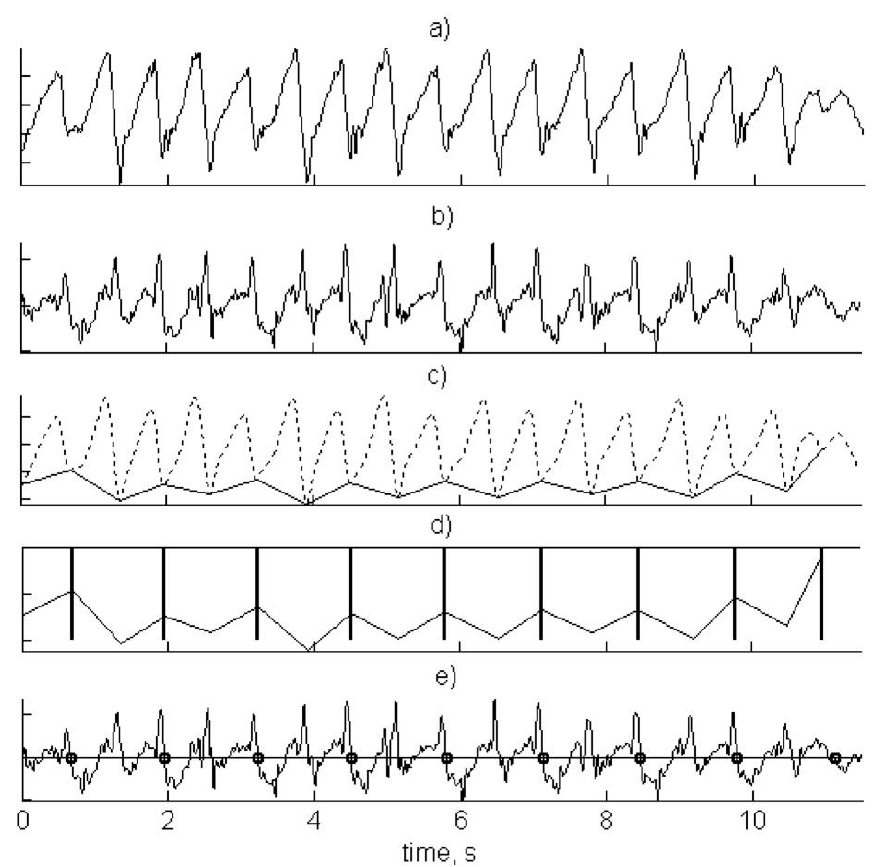
Figure 17. Stroke count detection method using back worn accelerometer: ( a ) raw vertical axis acceleration; ( b ) raw anterio-posterior axis acceleration; ( c ) filtered vertical axis acceleration; ( d ) filtered vertical axis acceleration with envelope applied; ( e ) stroke detection on anterio-posterior axis using peaks in envelope. Reproduced with permissions from Daukantas, Marozas and Lukosevicius [26].